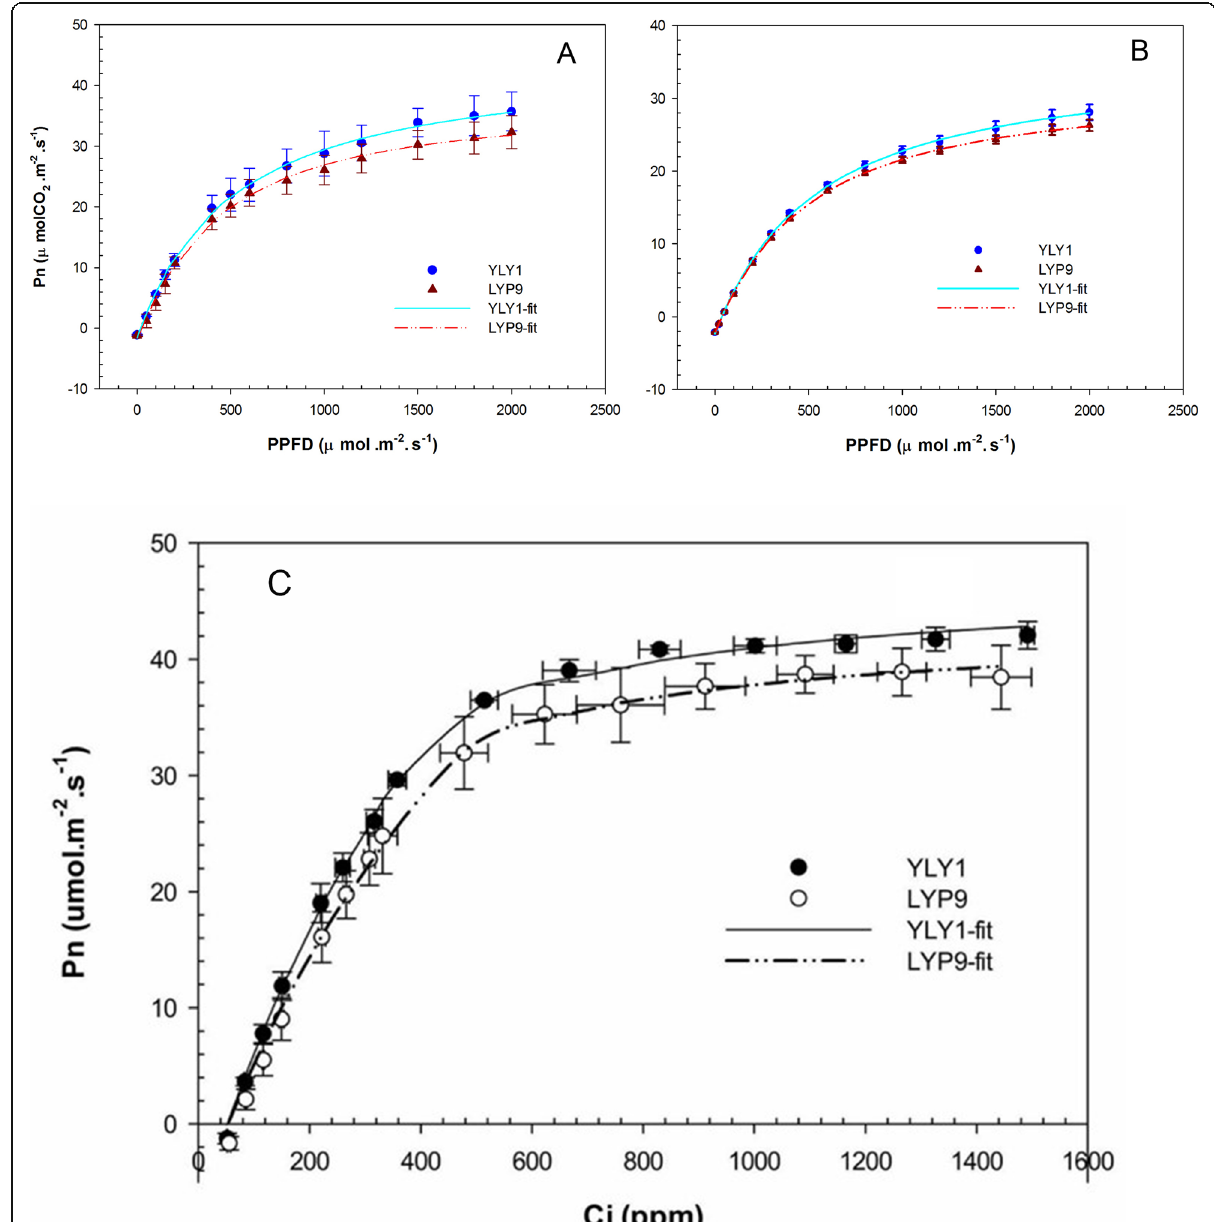
Fig. 2 The photosynthetic CO 2 uptake rates (P n ) under different photosynthetic photon flux densities in flag leaves at different developmental stages. a Early milk stage, b Late milk stage. The CO 2 concentrations used during the measurements were 380 – 400 ppm and 385 ppm for early milk stage and late milk stage respectively. The photosynthetic CO 2 uptake rates under different intercellular CO 2 concentration in flag leaves for YLY1 ( c ) and LYP9 ( d ) measured at the milk stage. During the measurements, the PPFD used was 1600 μ molm − 2 s − 1 . The bar is the standard deviations of 3